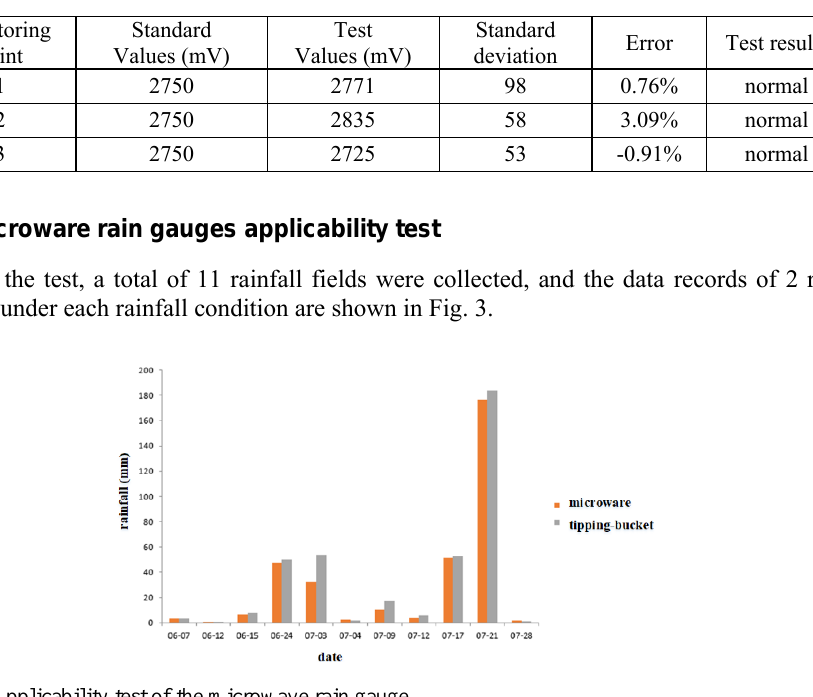
Table 3. Adaptability test results of rain gauges.